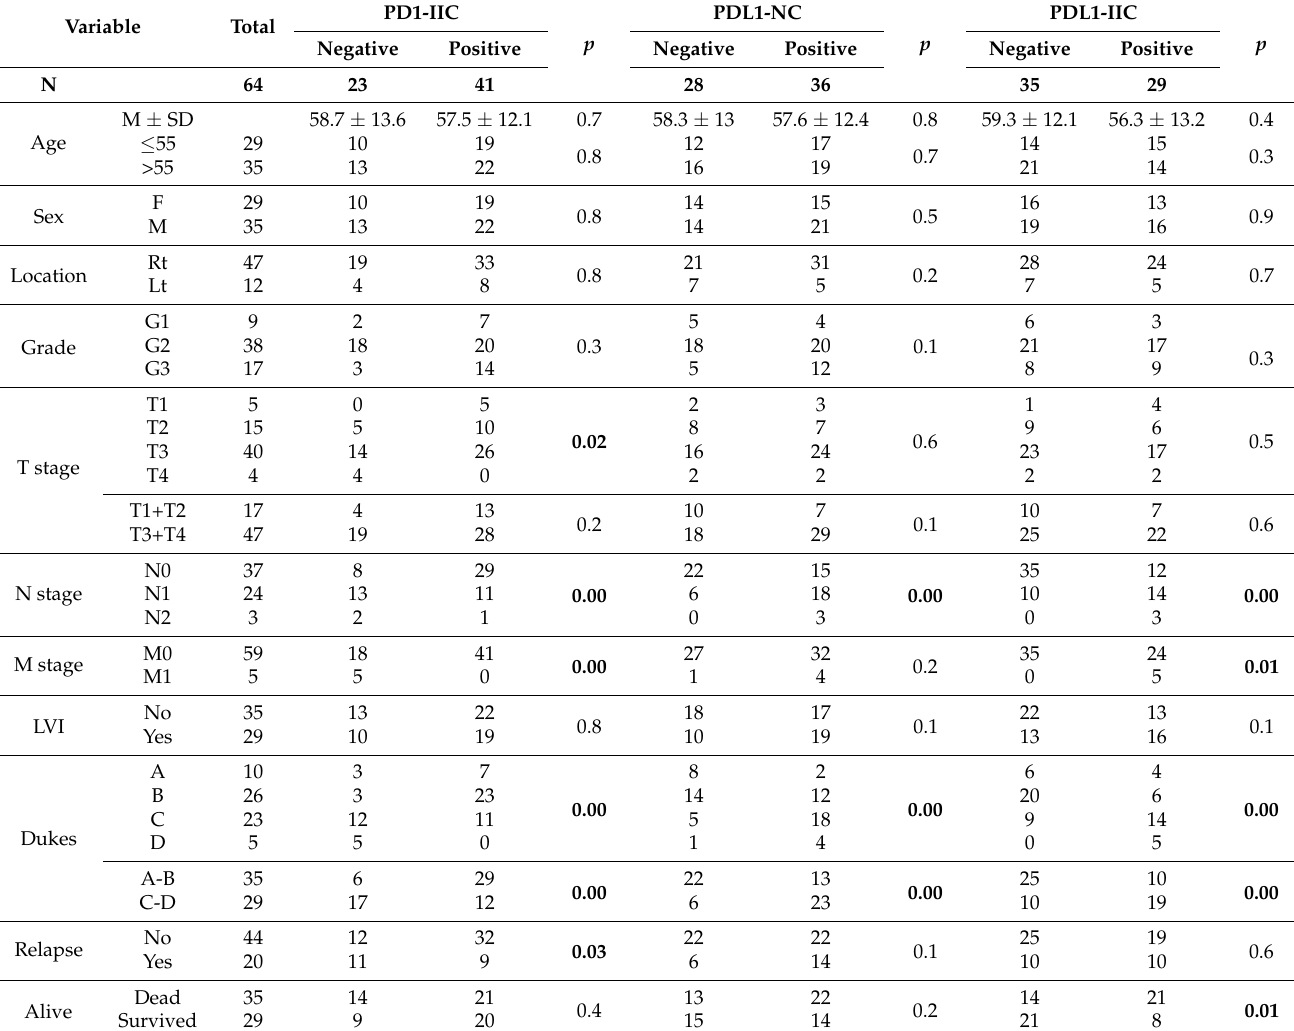
Table 3. Association of PD1 expression in IIC and PDL1 expression in NC and IIC and clinicopatho- logical prognostic factors of colorectal